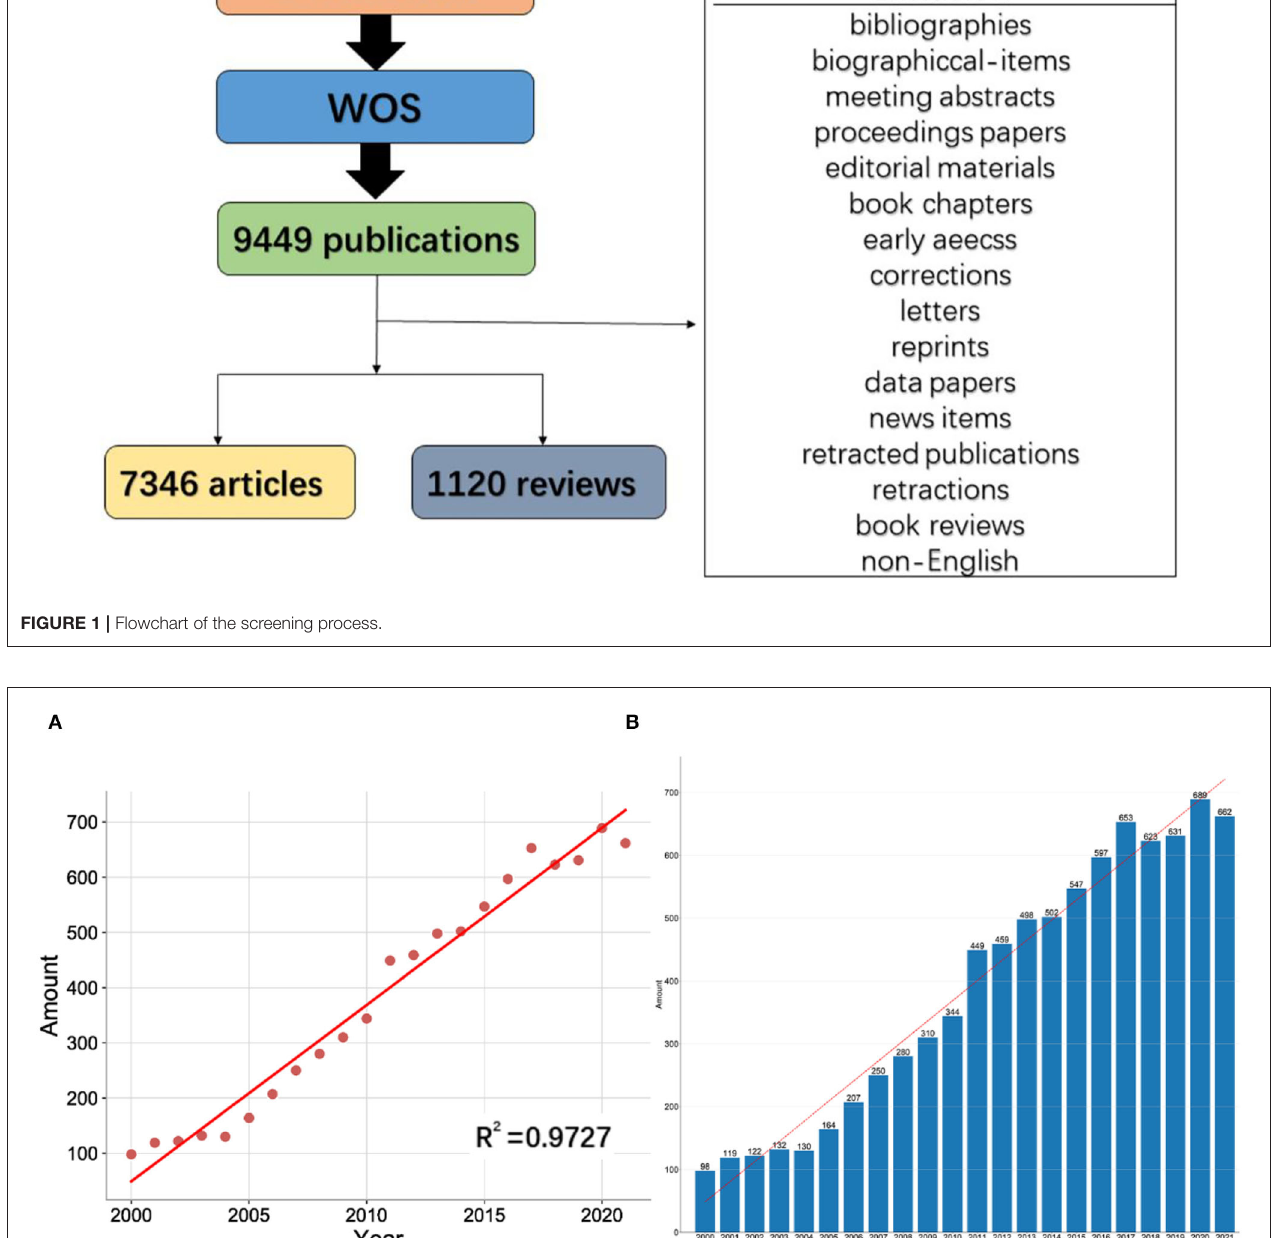
highest H-index (131), more than two times the number for India (54) and Nigeria (31). England had a moderately lower NP but higher H-index, NC, and average per item than China. Thailand achieved the highest average per item (53.74), followed by England (49.06), indicating that the publications of the